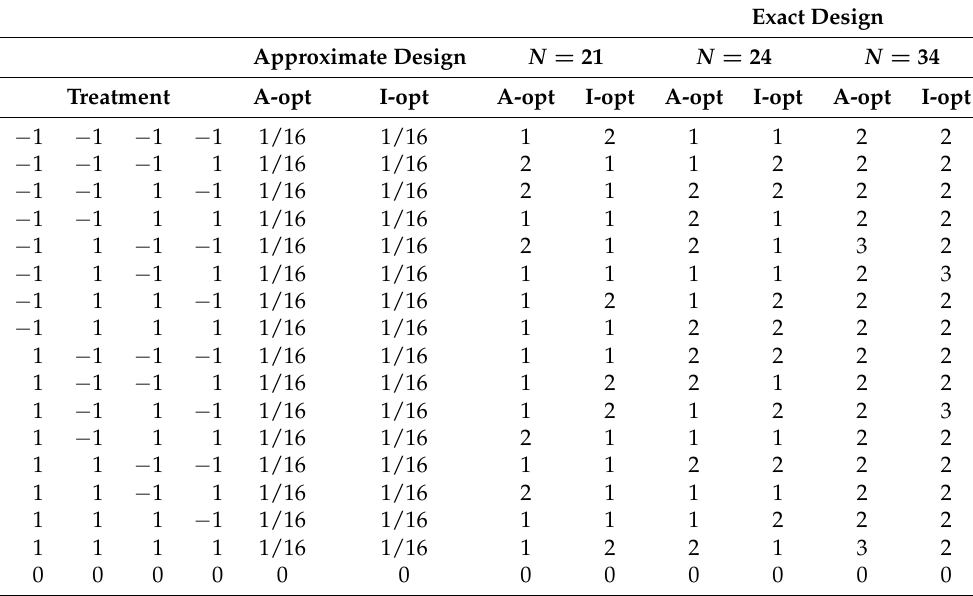
Table 8. A- and I-optimal designs for Model 3, where k = 17 and N = { 21,24,34 } .